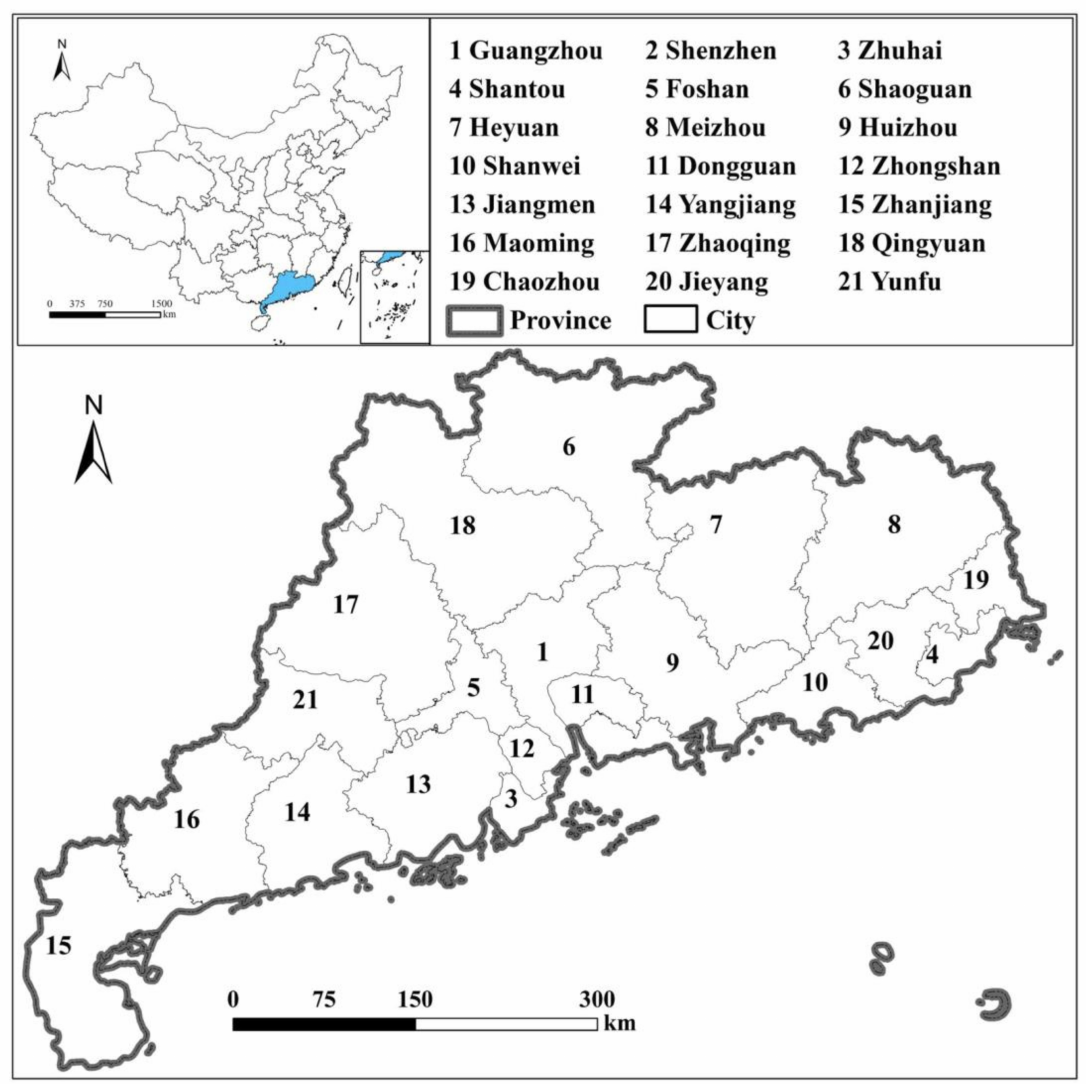
Figure 1. Administrative divisions in Guangdong Province, China. The blue area represents the Guangdong province in